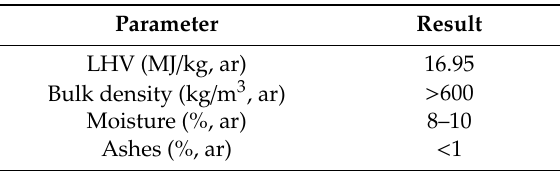
Table 2. Characterization of the density, moisture, lower heating value (LHV), and ashes of lab scale pellets as